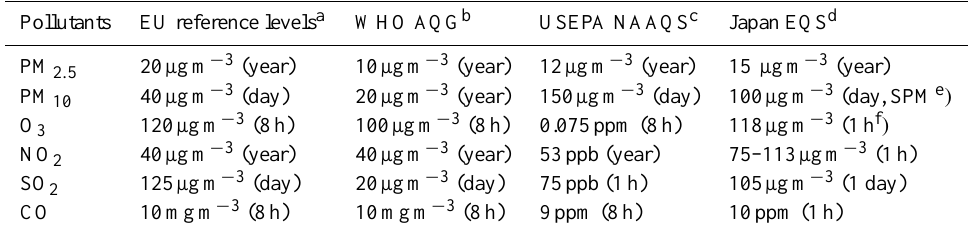
Table 1. Air quality standards for Europe (European Union reference values), WHO air quality guidelines (AQG), US-EPA National Ambient Air Quality Standards (NAAQS) and the Environmental Quality Standards (EQS) and guideline values for air pollutants in Japan. Values in brackets give time period for which the guideline is defined.